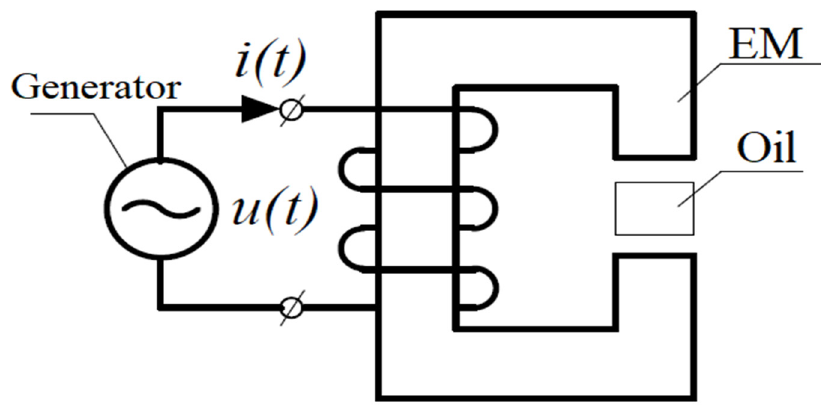
Figure 2. A schematic diagram of a 50 Hz electromagnetic oil treatment test setup.